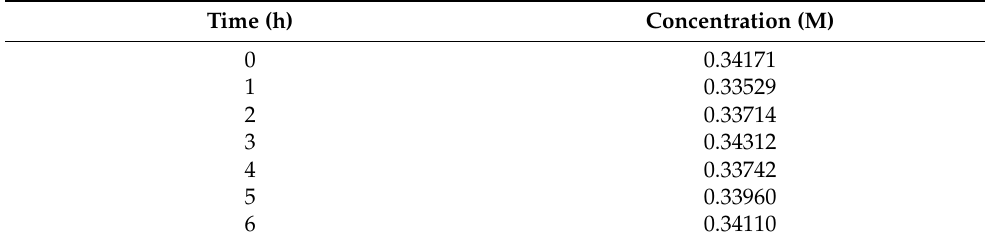
Table 1. Cumulative ethanol formed/consumed at different irradiation